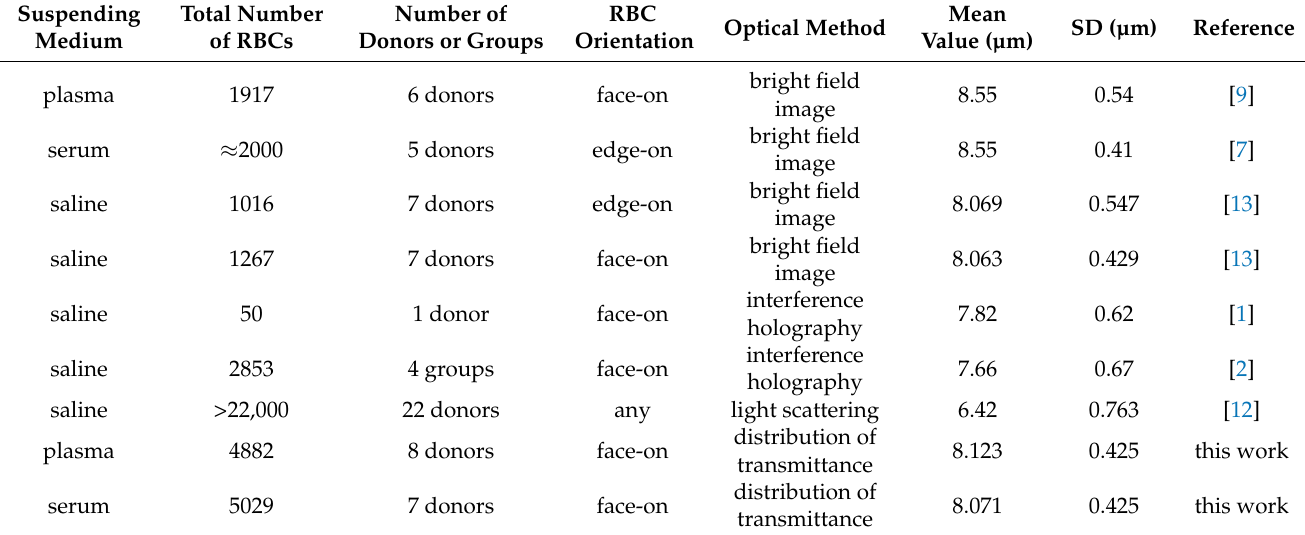
Table 4. Measurements of RBC diameter. The buffered salt solutions used in different experiments are subsumed under